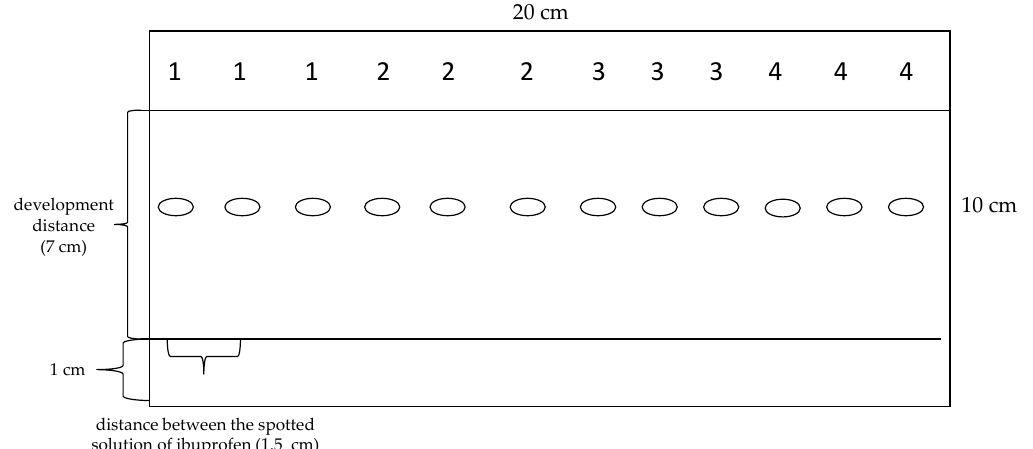
Figure 2. Scheme of application of ibuprofen solutions on chromatographic plate.